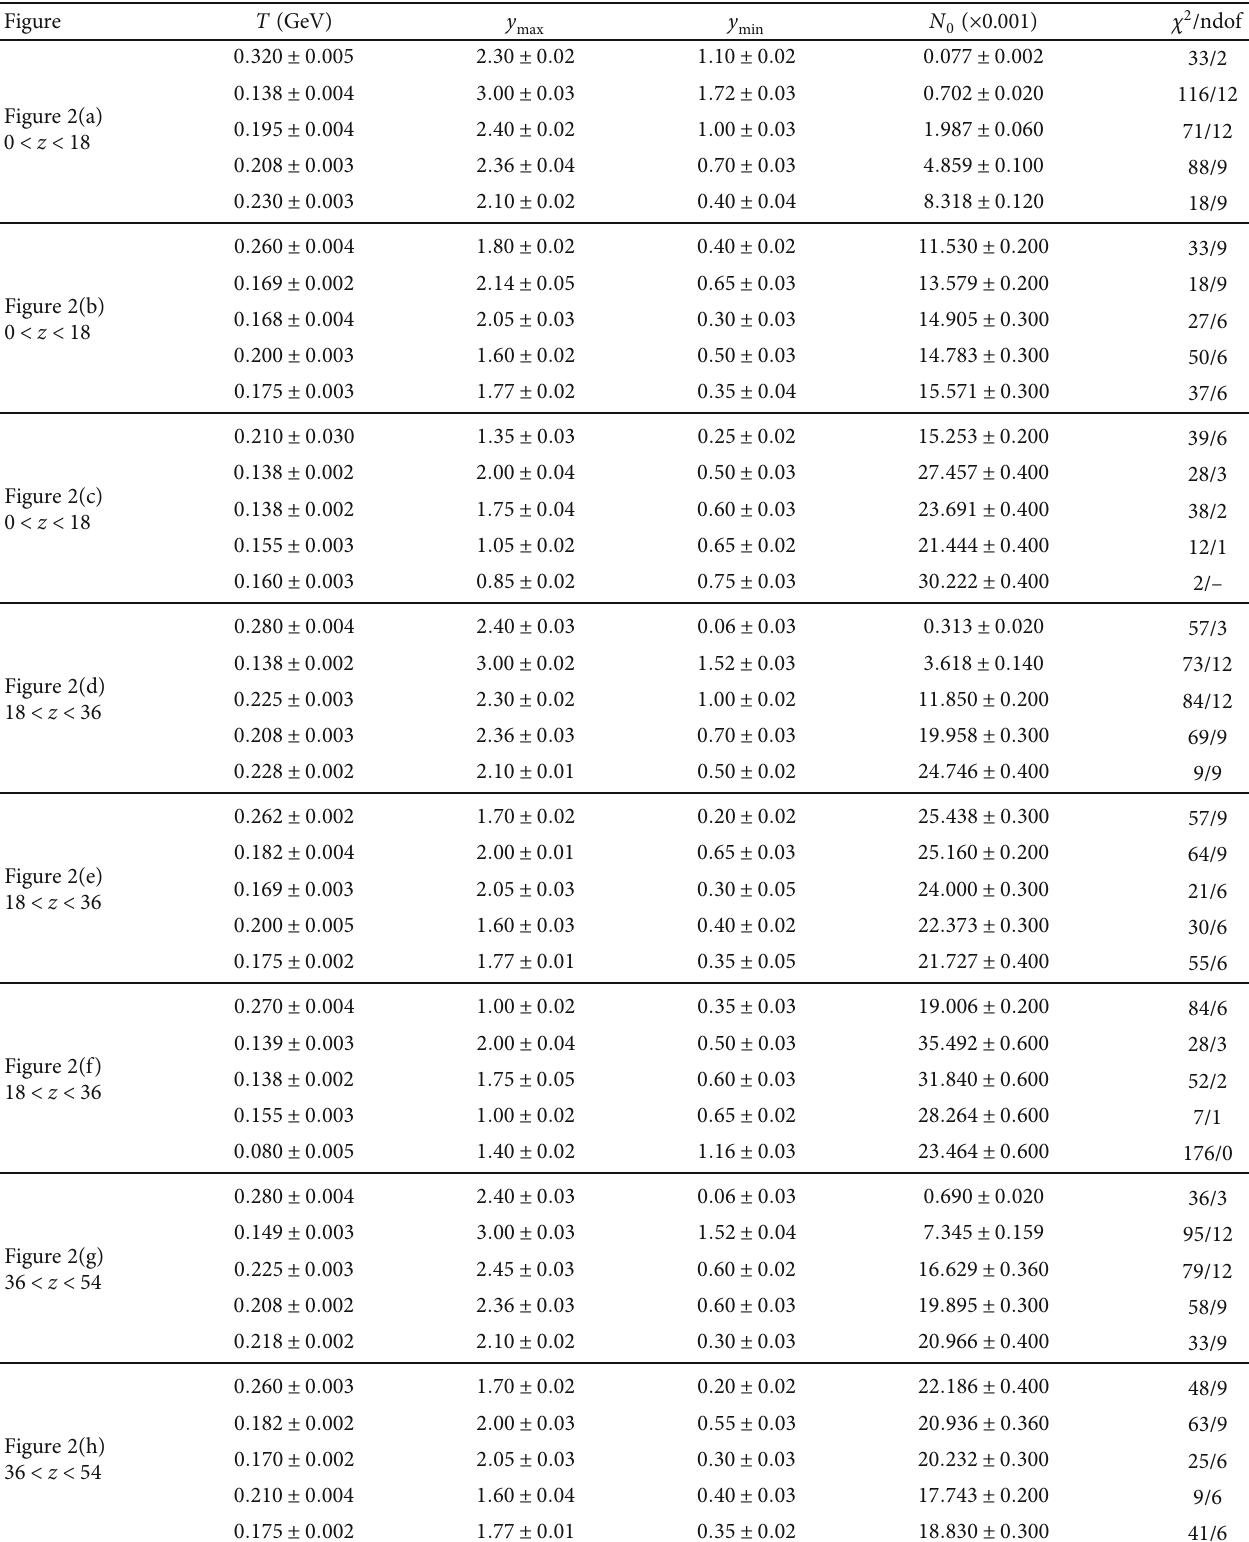
y N χ 2 , and ndof corresponding to the curves in Figure 2 in which di ff erent data are measured in di ff erent θ Table 2: Values of T , y 0 , max , min , and z ranges. In the table, z is in the units of cm and θ is not listed, which appears in Figure 2. In one case, ndof is negative which appears in terms of “–” and the corresponding curve is just for eye guiding